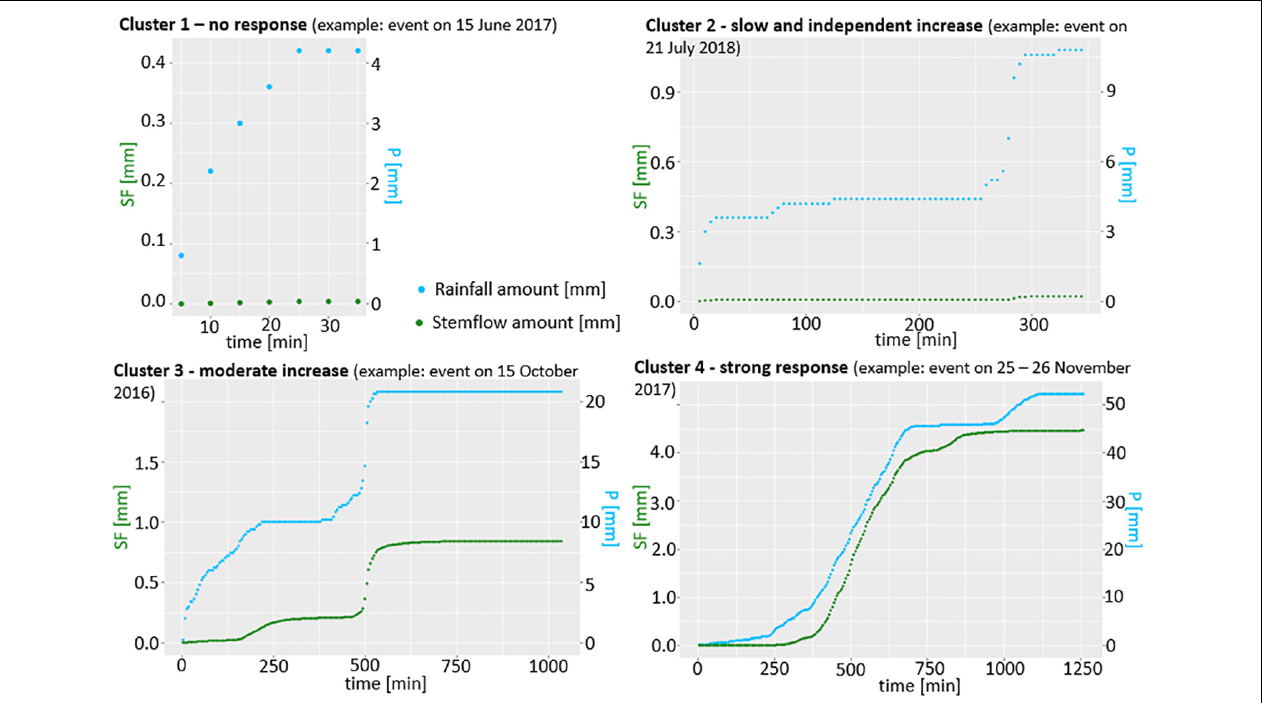
FIGURE 4 | Examples of figures showing typical development of stemflow and rainfall grouped in individual clusters (amounts of stemflow and rainfall are plotted as the sum of the detected amounts at 5-min time intervals; the left y-axis shows values of stemflow increased by a factor of 10, the right y-axis shows values of rainfall in the open).